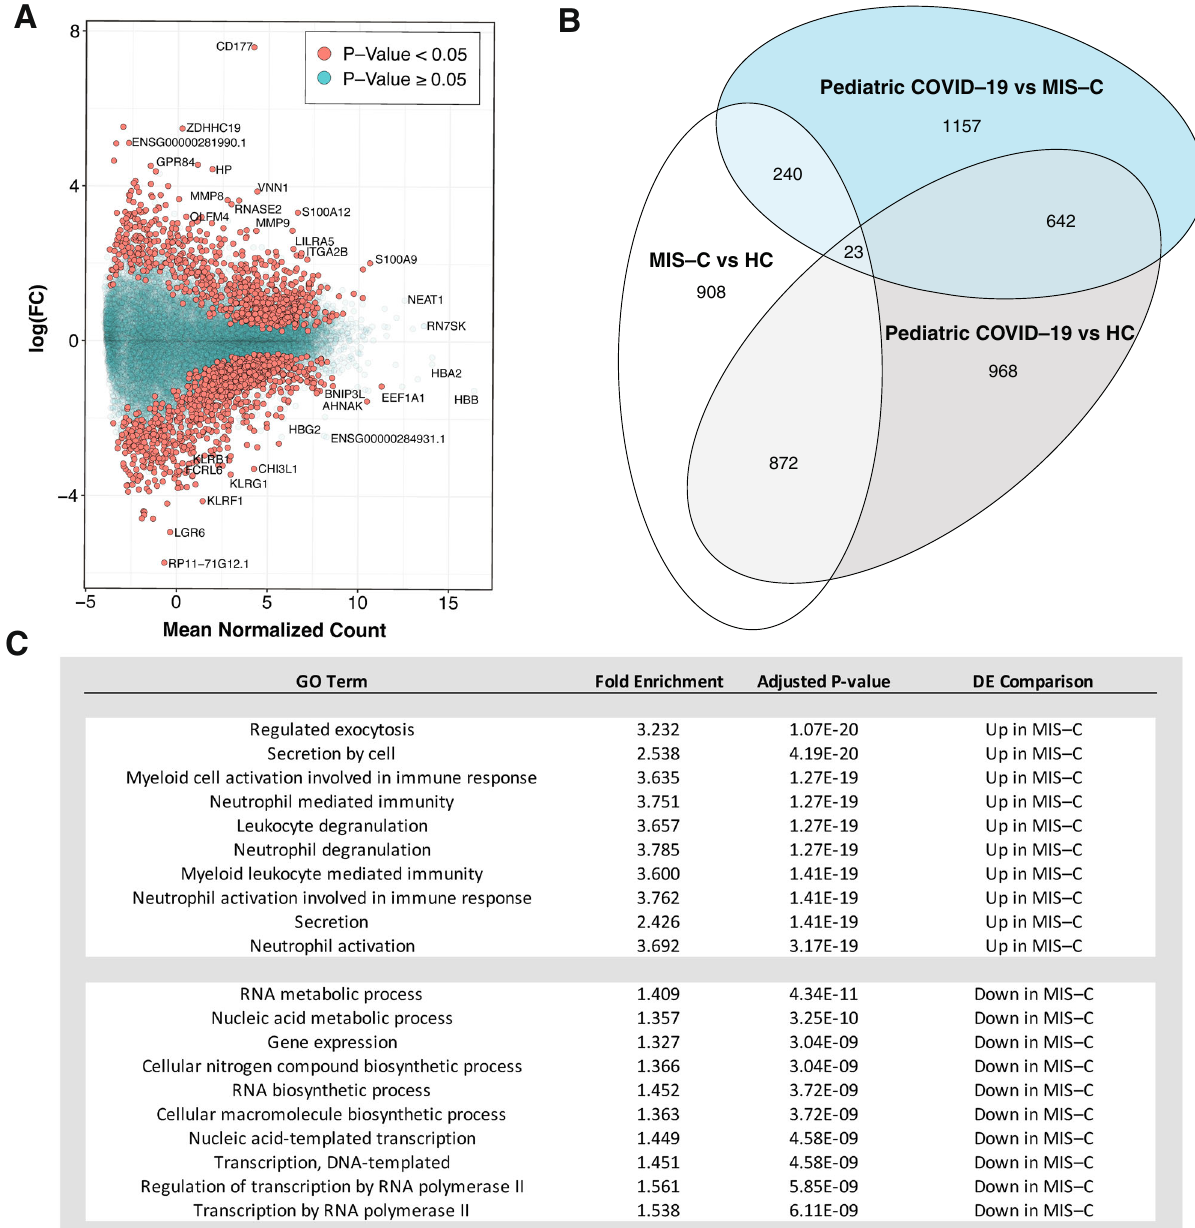
Fig. 2 Differential expression analyses identify the transcriptional signature of MIS-C. A Differential expression (DE) analysis for MIS-C patients versus HCs. The x -axis is the mean normalized count for each gene and the y -axis is the log 2 (fold-change) for the differential expression. Positive and negative log 2 (fold change) represent genes upregulated and downregulated in MIS-C, respectively, and the signi fi cance of association between gene expression and MIS-C status is indicated by the color of the dots as de fi ned in the legend. B Overlap of MIS-C and pediatric COVID-19 transcriptional signatures: Venn diagram of the overlap of genes across DE signatures. Each comparison is labeled on the plot. C GO terms for MIS-C signature: GO term enrichment results for the top 10 upregulated and downregulated processes in MIS-C compared to HCs. Two-sided Fisher tests were used and p -values were adjusted for multi-testing as described in the “ Methods ” section. Full DE results and pathway enrichments for all comparisons in B can be found in Supplementary Data 7 and